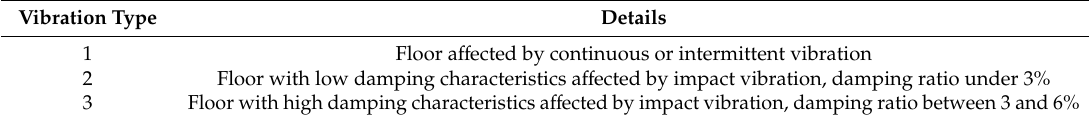
Table 11. Natural frequency and maximum acceleration [11].